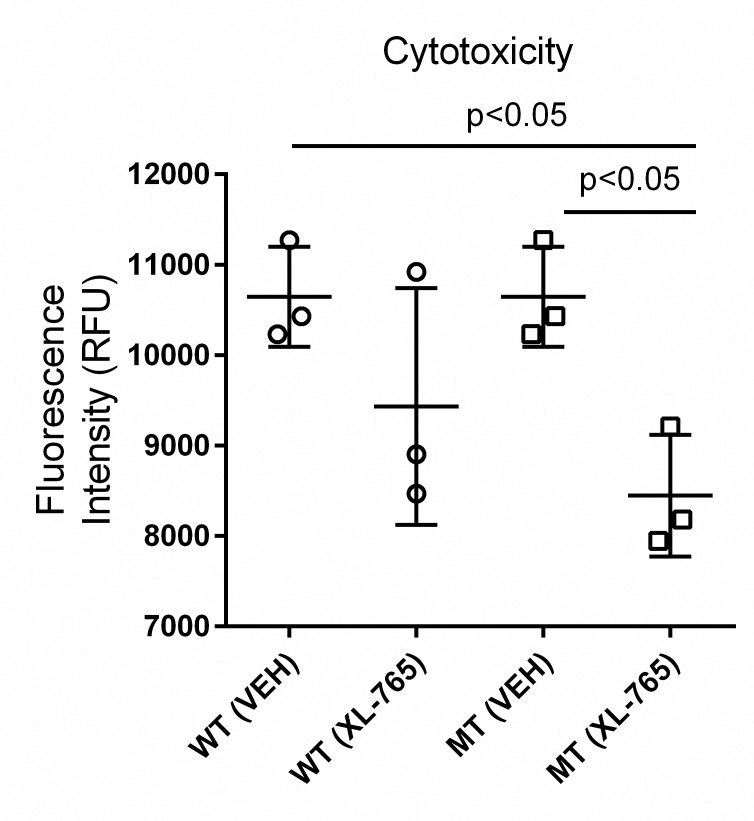
Fluorescence detection of cellular toxicity as a function of starvation or treatment with the mTOR inhibitor, XL-765.NSCs were exposed to vehicle (0.01% DMSO) or XL-765 (see Methods) for 24 h, then starvation conditions were implemented for 6 h followed by fluorescence quantification to assess cytotoxicity. Each symbol (square) represents the measurement of each biological replicate. Each horizontal line reflects the mean of the 3 independent experiments and error bars represent SD. When present, XL-765 was used at 10 nM in DMSO (0.01%) for 24 h, otherwise vehicle matched controls were employed. Note that a lower value within genotype represents decreased cytotoxicity. Abbreviations: RFU, relative fluorescence units; WT, wild-type; MT, mutant; VEH (0.01% DMSO); XL-765, treatment with XL-765. Statistical analysis employed one-way ANOVA with post-hoc analysis (F (3, 8) = 4.895; p < 0.05).